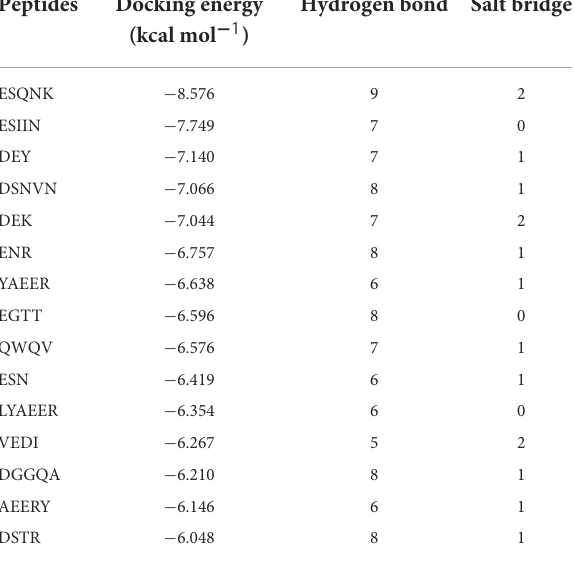
TABLE 2 The molecular docking energy between fermented egg-milk peptides (FEMPs) and AKT (The top 15). Peptides Docking energy − 1 (kcal mol